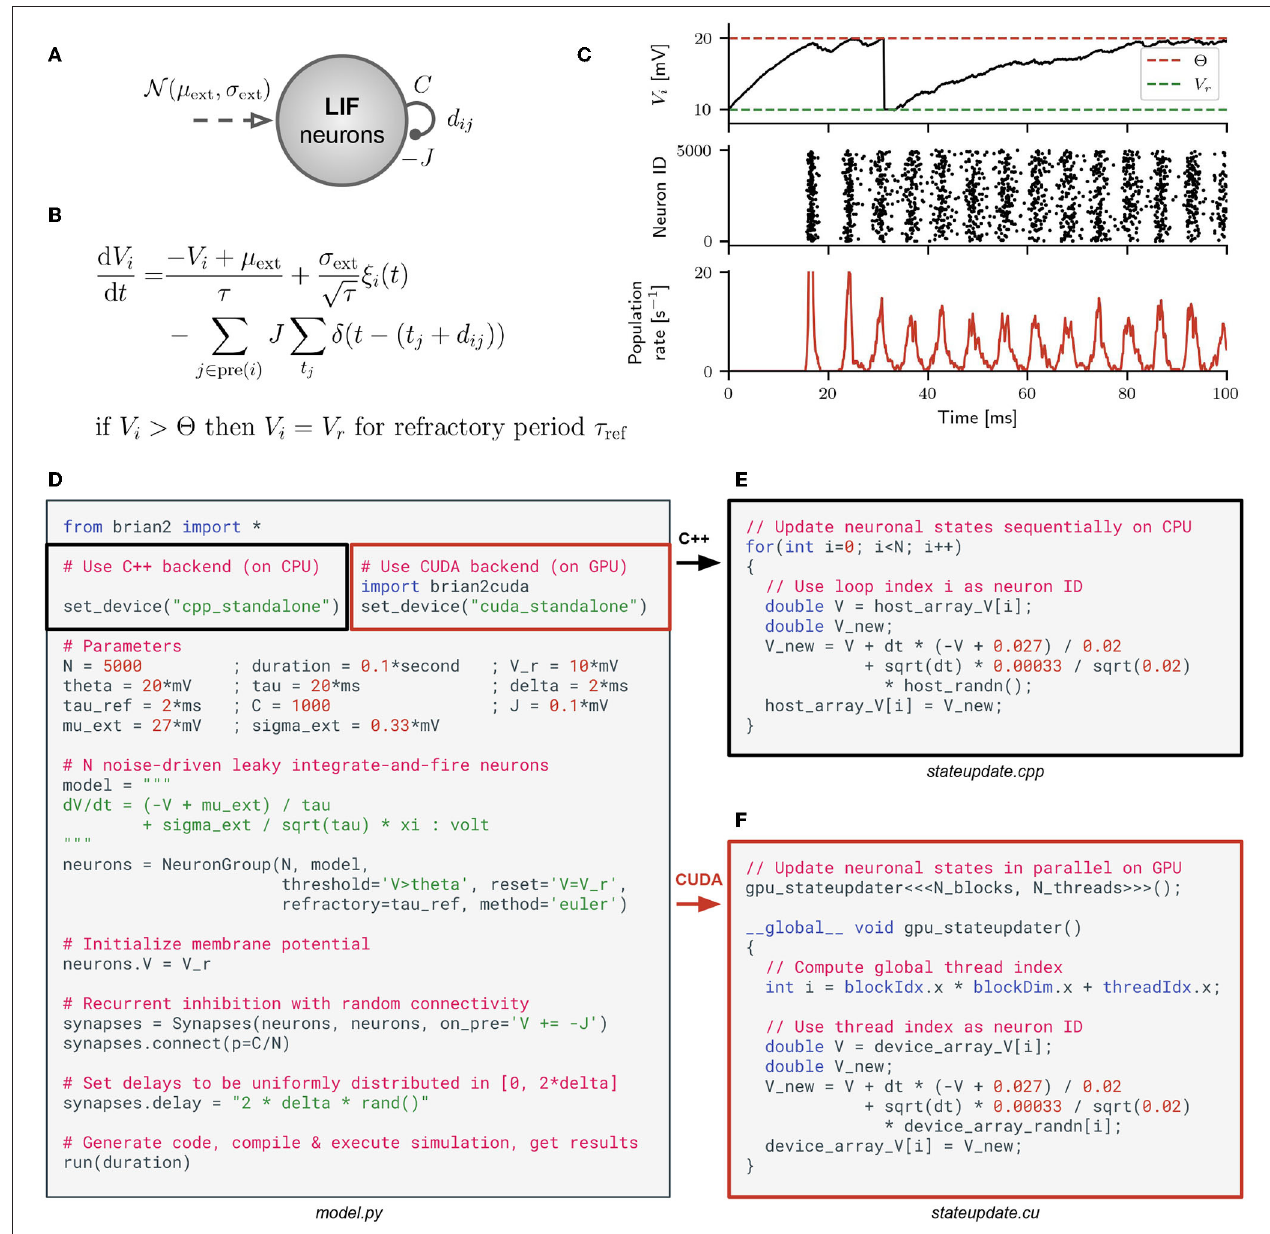
FIGURE 1 | Brian model definition and C++/CUDA code generation. (A) Population of leaky integrate-and-fire (LIF) neurons with recurrent inhibitory coupling J , average number of random synapses per neuron C and synaptic transmission delays d ij between neurons j and i . The neurons are driven by external Gaussian white noise with mean µ ext and standard deviation σ ext (model from Brunel and Hakim, 1999). (B) Corresponding stochastic differential equation defining the dynamics of the membrane potential V i of a single LIF neuron i [with i = 1, ... , N ; membrane time constant τ ; unit Gaussian white noise process ξ i ( t ) that is uncorrelated across neurons; j ∈ pre( i ) runs over all neurons j that are presynaptic to neuron i ; t j are all spike times of neuron j ; Dirac delta function δ ( x )]. When the voltage V i crosses threshold 2 , the neuron spikes and is set to the reset voltage V r for a refractory period τ ref . (C) Network dynamics from simulating the model with N = 5000 LIF neurons in Brian. Top panel: voltage trace for one exemplary neuron i . Middle panel: raster plot of the spike times for all neurons in the network. Bottom panel: instantaneous mean firing rate across all neurons. (D) A Python script implementing the model in Brian, either with its C++ backend (black blox) or with Brian2CUDA’s CUDA backend (red box). In this example, the synaptic transmission delays are independently sampled from a uniform distribution d ij ∼ U (0,4)ms. (E) Simplified version of generated C++ code to update all neuronal states defined by the voltages V i when using the C++ backend in Brian. (F) The same for the CUDA backend in Brian2CUDA. Here the CUDA kernel gpu_stateupdater is launched with N blocks × N threads parallel threads.